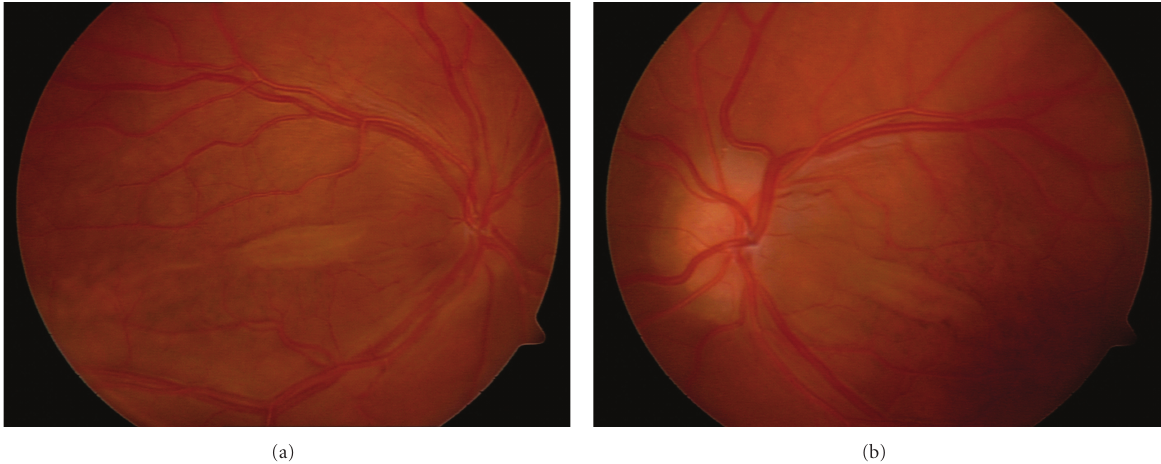
Figure 1: Fundus photographs of case 2 show elevated papillomacular retinal fold and crowded optic disc ((a): right, (b): left).